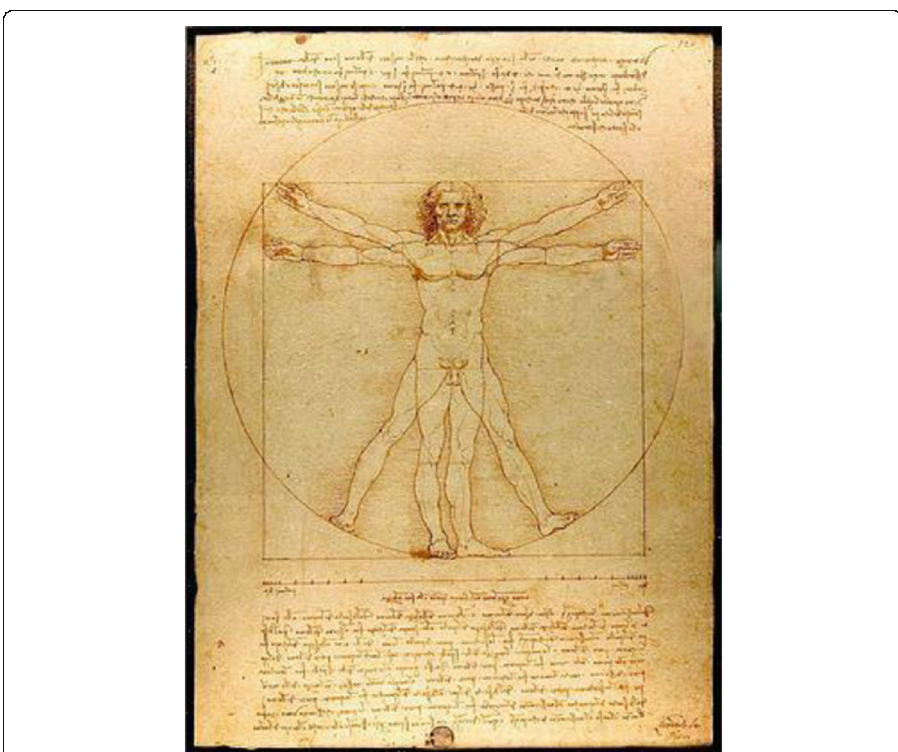
Fig. 1 Drawing of Vitruvian Man, Leonardo da Vinci,